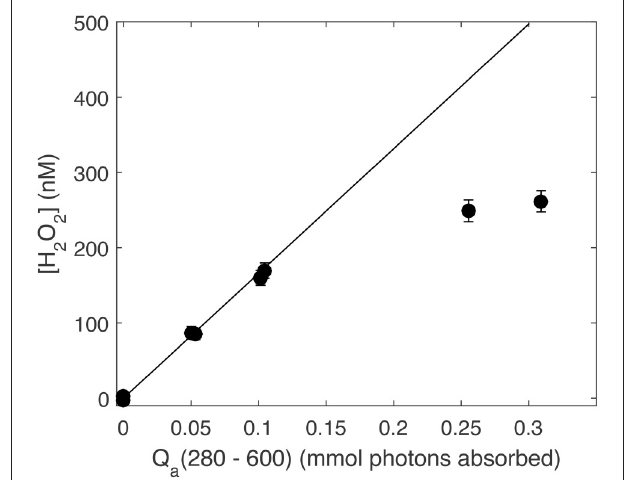
FIGURE 1 | H 2 O 2 (nM) generation during a 15min irradiation of Skidaway River Estuarine (SRE) water with various concentrations of added superoxide dismutase (SOD; Units L − 1 based on the manufacturer’s assay).